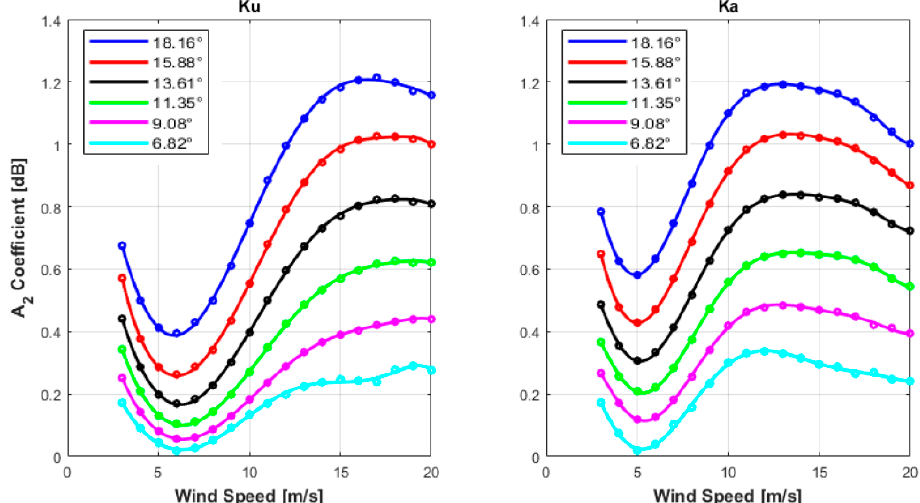
Figure 12. A 2 coefficient of KuPR( left ) and KaPR ( right ) σ 0 models (in dB) as a function of wind speed at different earth incidence angles. The symbols are Fourier coefficients while the solid lines represent their 7th order regression fits.